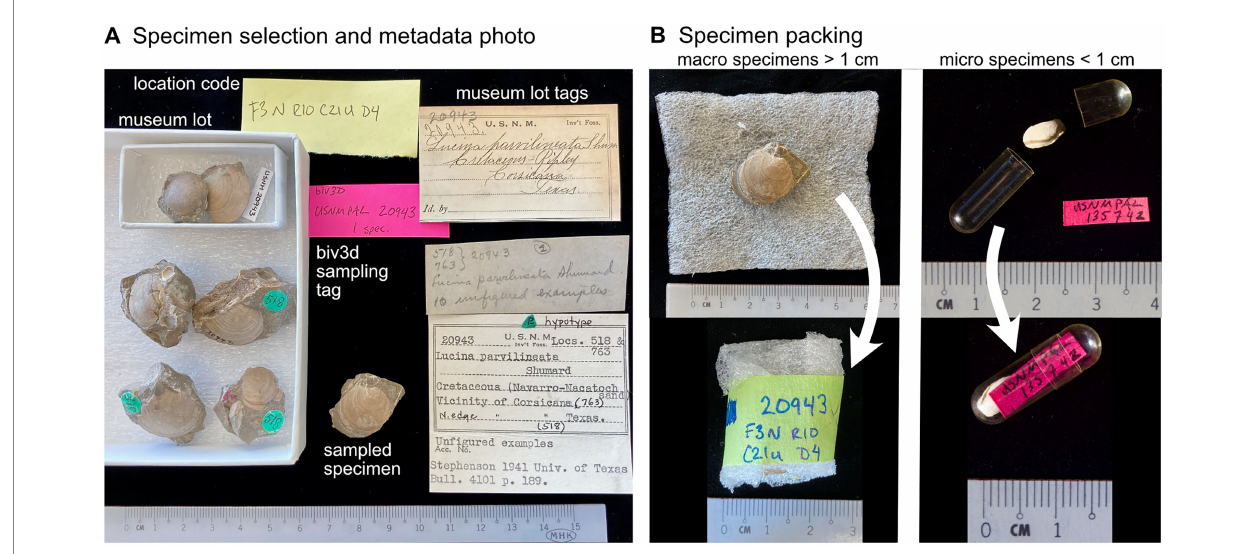
FIGURE 1 Workflow for sampling and packaging specimens from collections for scanning. (A) Museum lot with target specimen of Late Cretaceous fossil “ Lucina ” parvilineata Shumard 1861 to be imaged and temporary note marking number of specimens or valves sampled (as “biv3d sampling tag”). Location code gives the physical location of the specimen in the museum, here: Floor 3 North, Row 10, Case 21 upper, Drawer 4. (B) Macro specimens (>1 cm) are wrapped in pliable foam and secured with painter’s tape, noting the registration number and the specimen’s physical location code in the museum. Micro specimens (<1 cm) are placed in gel caps with a tag containing registration number and the specimen’s physical location in the museum (on the back of tag in this image).